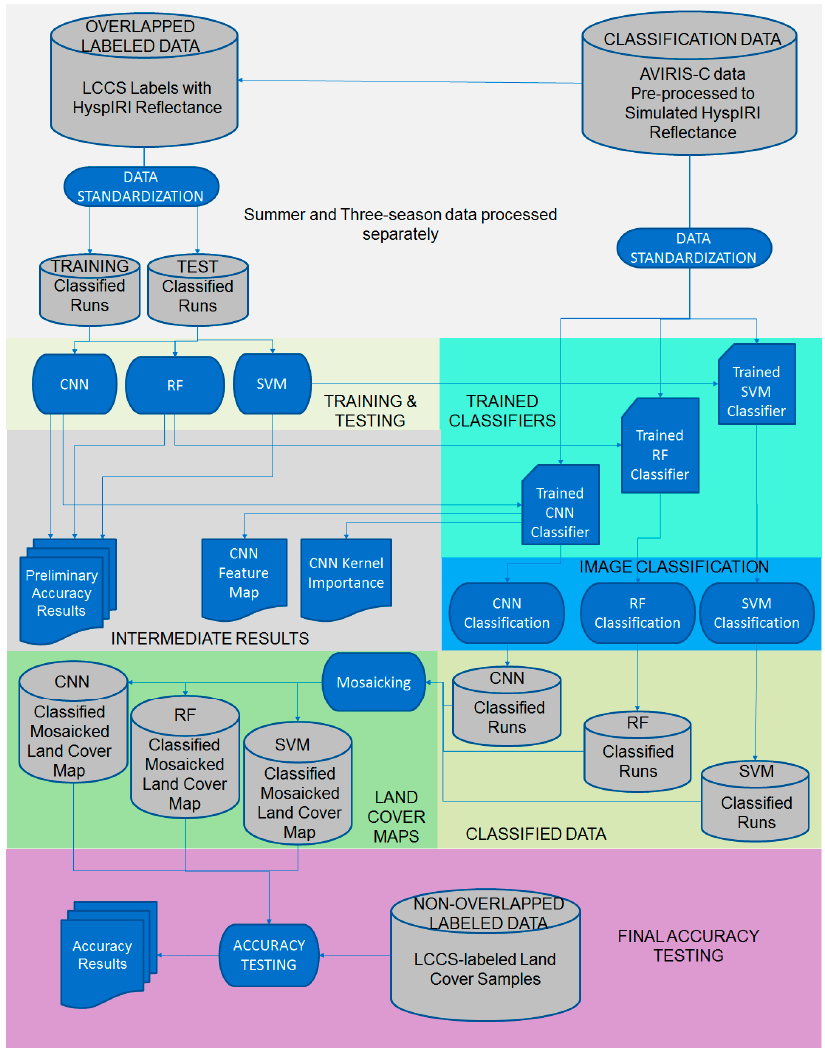
Figure 4. Overview of machine learning classification and accuracy assessment methodology.